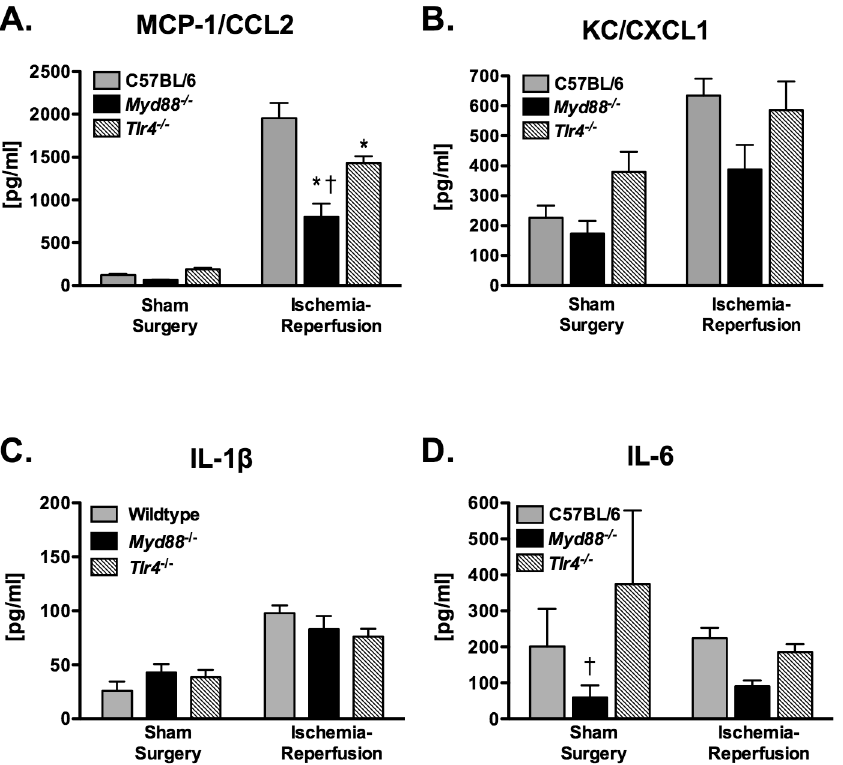
Figure 2. Cytokine concentrations from the left lung of mice subjected to 1 hr of left lung warm ischemia and 4 hr of reperfusion (n = 12/grp for C57BL/6 and Tlr4 -/- ; n=10 for Myd88 -/- ). Sham surgery mice (n = 4/grp) were subjected to the same procedure except for left lung ischemia. *p ≤ 0.05 when compared with C57BL/6 mice. † p ≤ 0.05 when compared with Tlr4 -/- mice. doi: